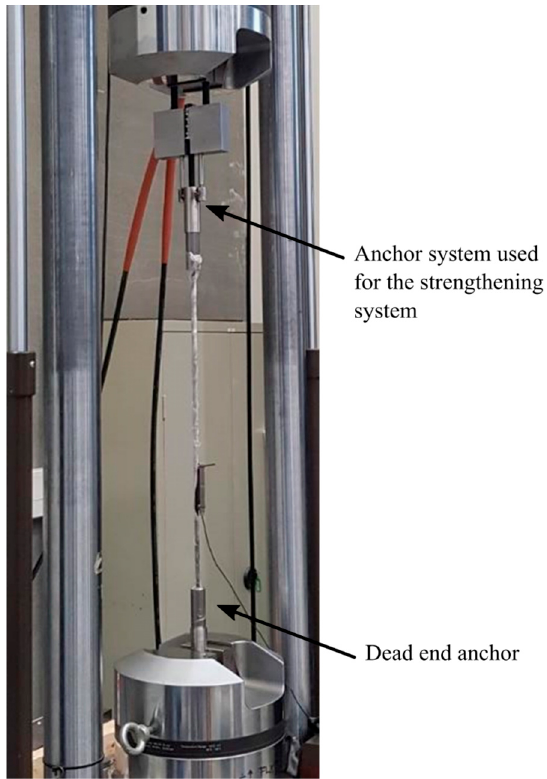
Figure 12. Tension test performed on the anchor system. Photograph by the authors.